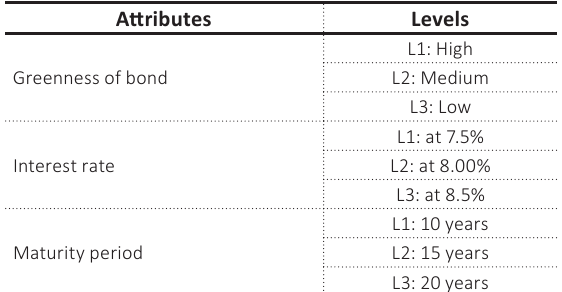
Table 1. Attributes and attributes